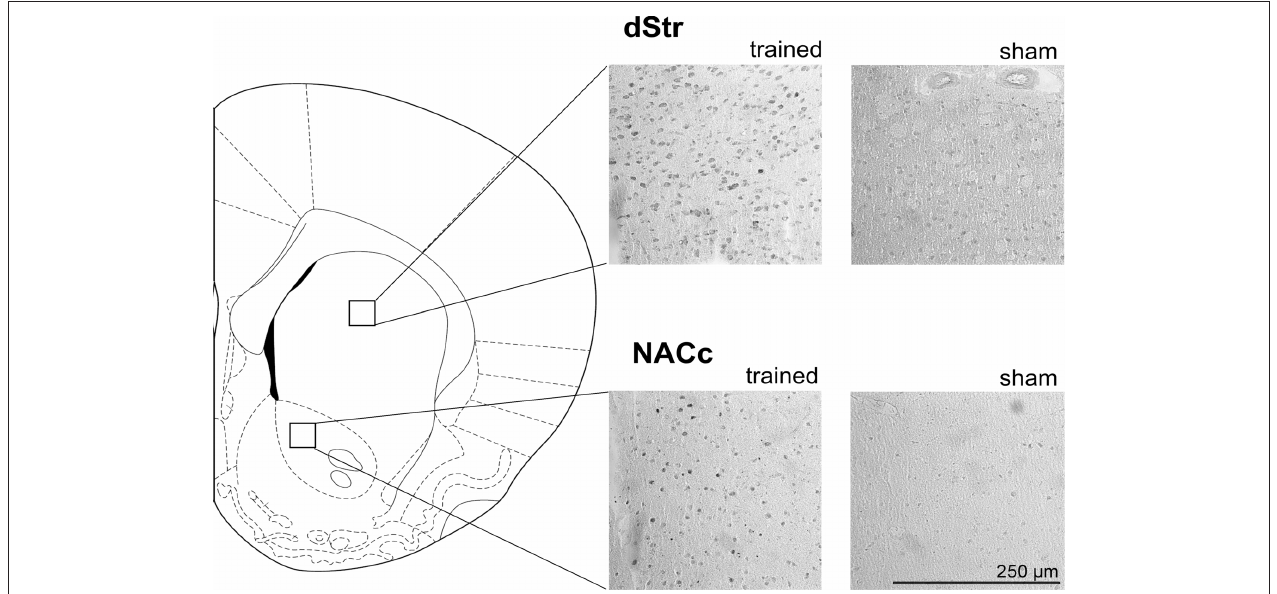
randomly placed for cell counting. Pictures show c-fos staining with DAB in dStr (top) and NACc (bottom) at 20 × magnification for rats undergoing either odor conditioning (trained) or sham training